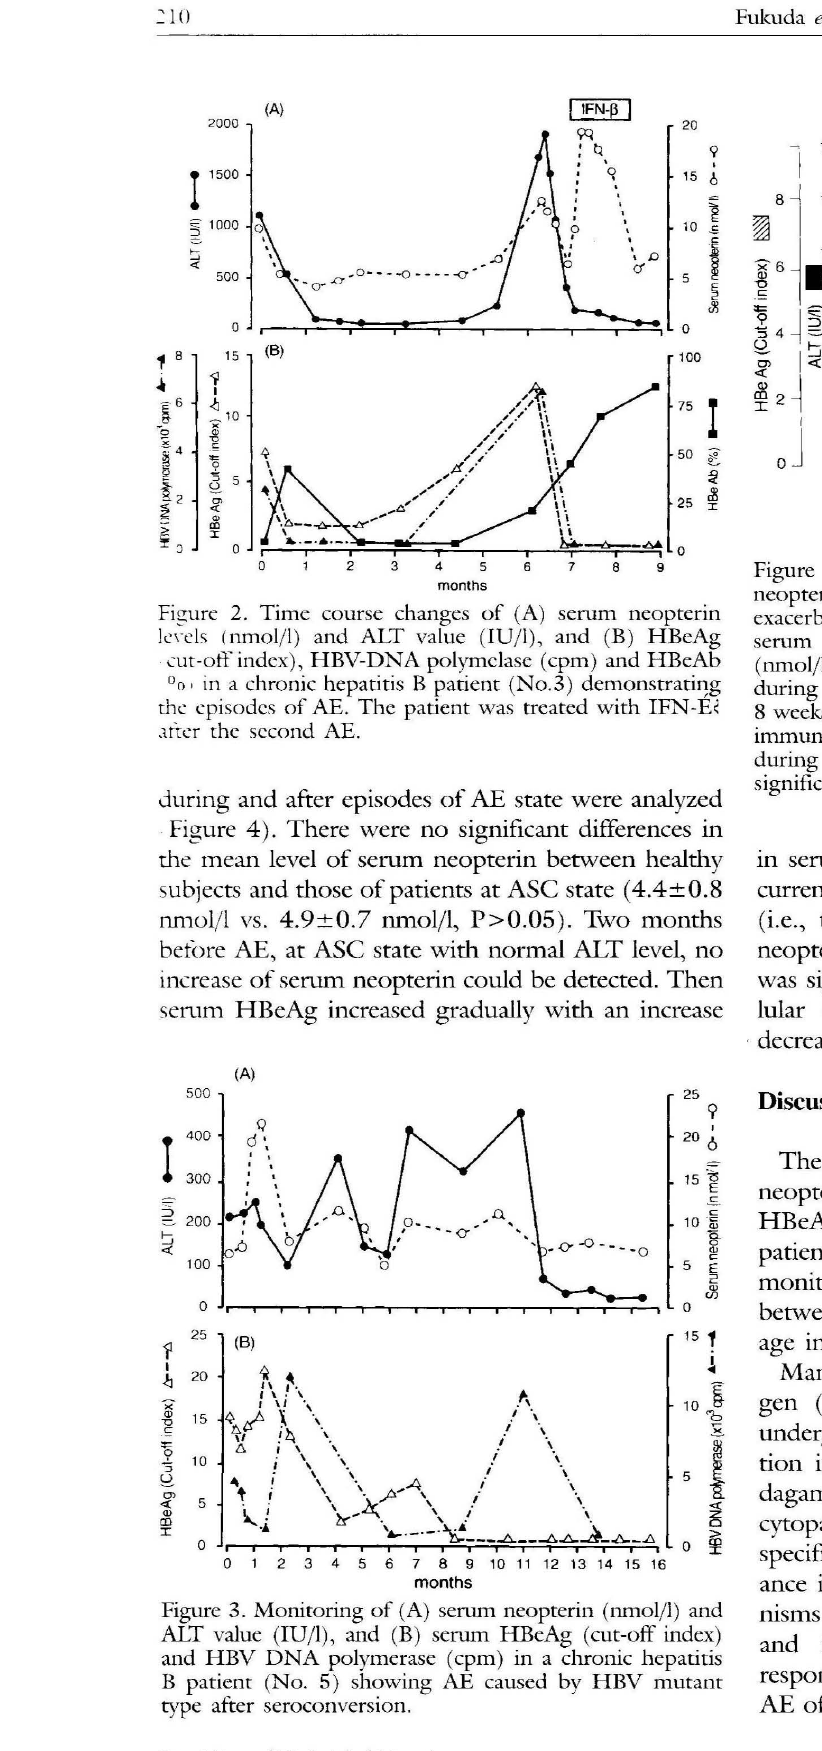
Figure 3. Monitoring of (A) serum neopterin (nmol/l) and ALT value (IUjl), and (B) serum HBeAg (cut-off index) and HBV DNA polymerase (cpm) in a chronic hepatitis B patient (No.5) showing AE caused by HBV mutant type after seroconversion. Pteridines / Vol. 10 / No. 4